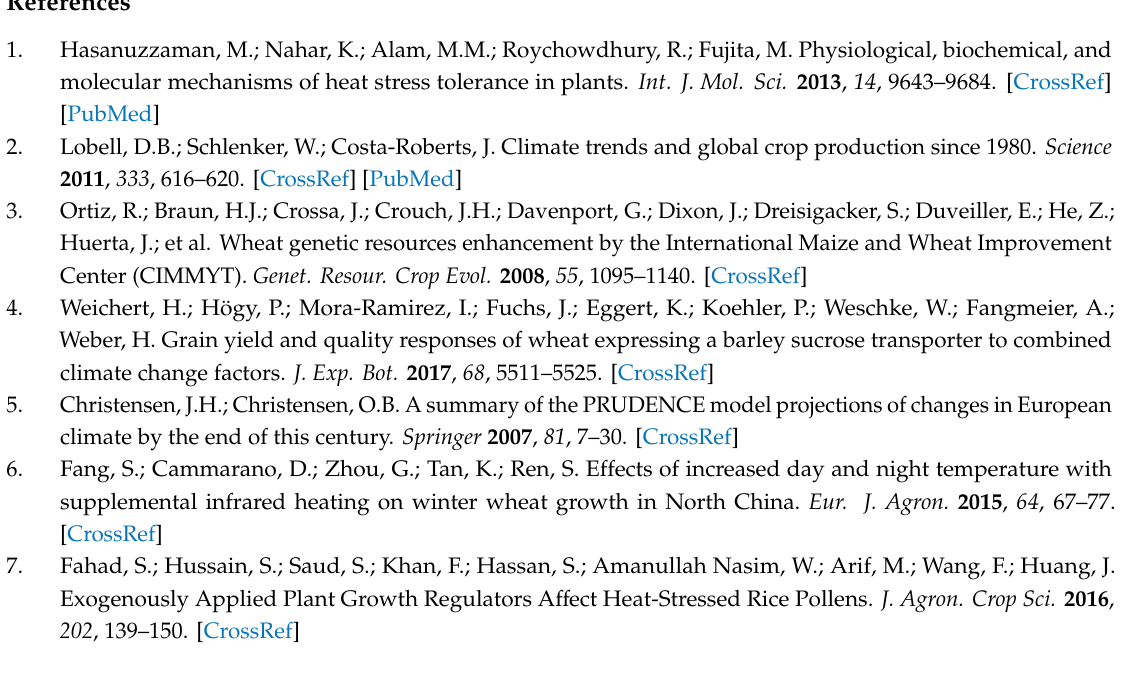
Supplementary Materials: The following are available online at http: // www.mdpi.com / 2073-4395 / 10 / 11 / 1730 / s1, Figure S1 : Daily temperatures, Maximum (Max), minimum (Min); (a) March and April 2015, (b) March and April 2016 at the experimental station of Assiut University; Figure S2 : Histogram shows the distribution of the traits under control and pre-anthesis heat in barley; (a) Yield per plot (YPP), (b) Thousand kernel weight (TKW), (c) Day to flowering (DTF), (d) Chlorophyll content at flowering, (e) Water content (WC), (f) Protein content (PC), (g) Carbohydrates (Carb), (h) Starch (Str) and (i) Proline (Pro). Table S1: List of barley genotypes used in this study; Table S2 : List of all significant SNPs associated with the traits in barley under control and heat stress during anthesis and seed set; Table S3 : Full description, annotation, and orthologs of the candidate genes on chromosomes 1H and 4H associated with the traits in barley under control and heat during flowering and seed set. The potential genes on each chromosome were considered in the discussion section are highlighted